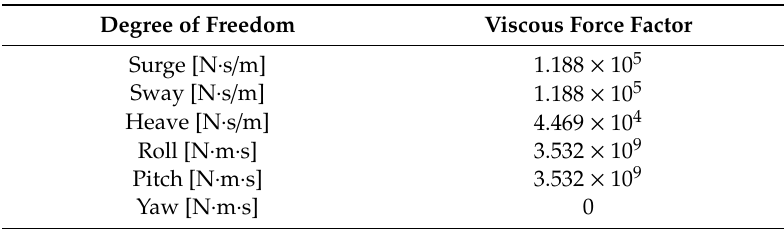
Table 3. Viscous force factors used for the